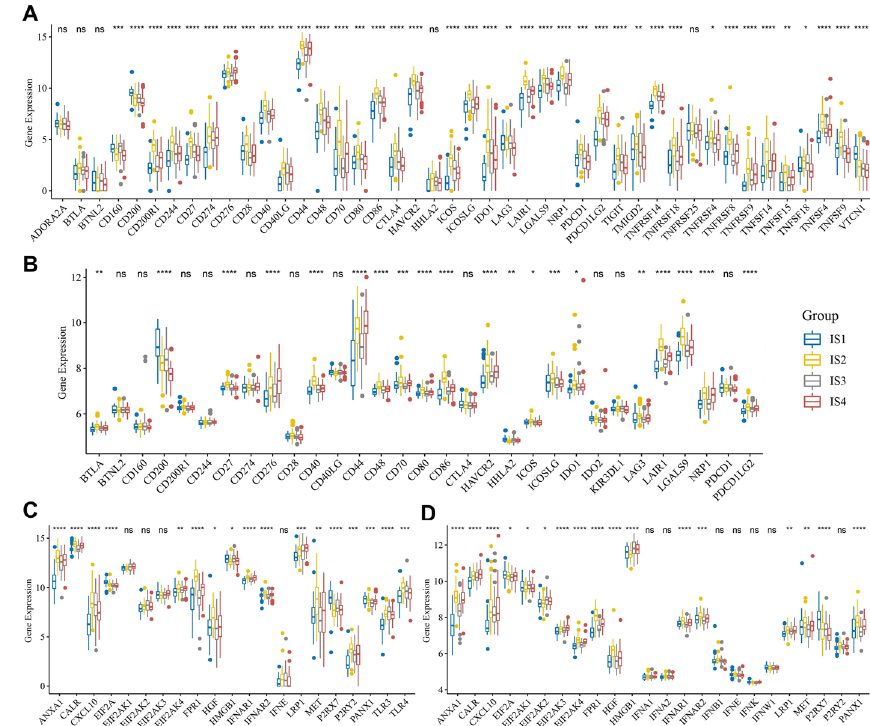
Fig. 4 Association between immune subtypes and immunomodulators in GBM. Differences in expression levels of ICP-related genes among GBM immune subtypes in the TCGA cohort ( a ) and the REMBRANDT cohort ( b ). Differences in expression levels of ICD-related genes among GBM immune subtypes in the TCGA cohort ( c ) and the REMBRANDT cohort ( d ). * p < 0.05, ** p < 0.01, *** p < 0.001, **** p <